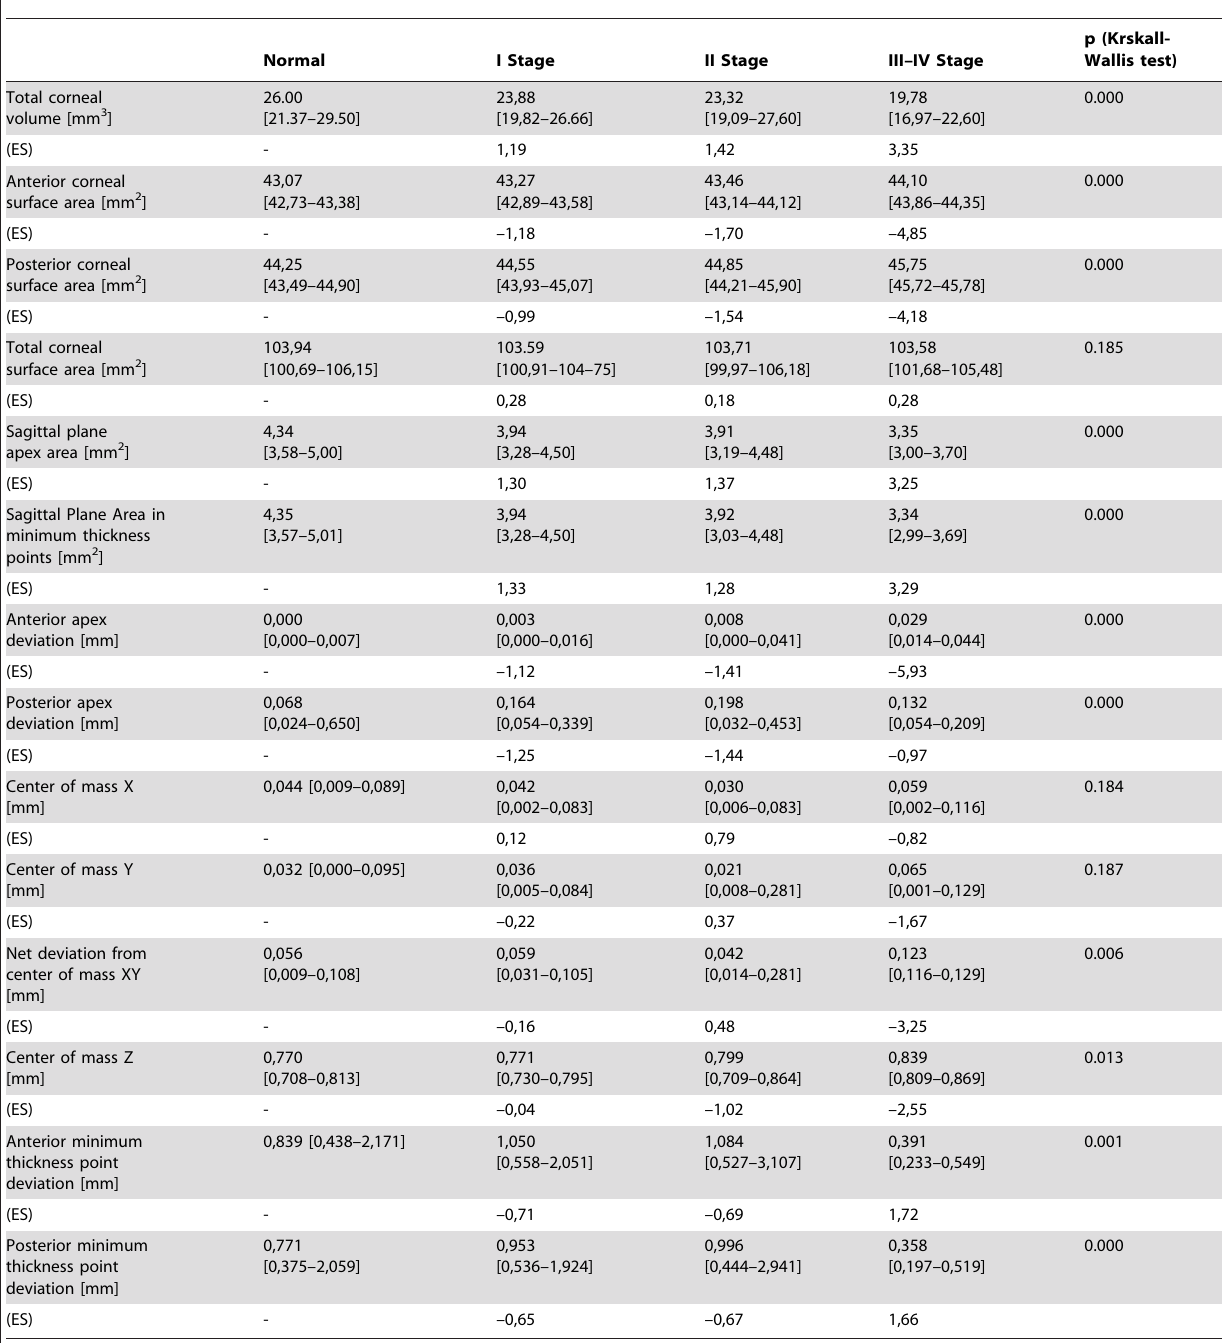
Table 3. Comparison between groups of the outcomes modeled; Kruskall-Wallis test (with p values) and effect size, (ES) 1 .